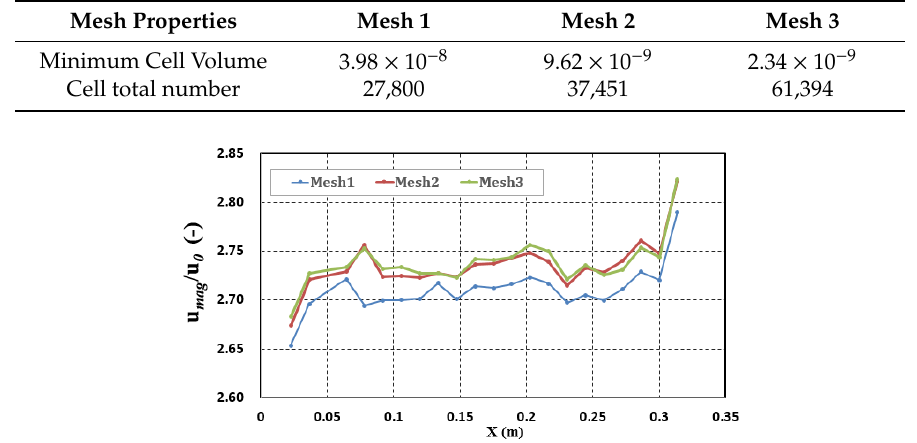
Figure 5. Comparison of velocity profiles for different meshes.